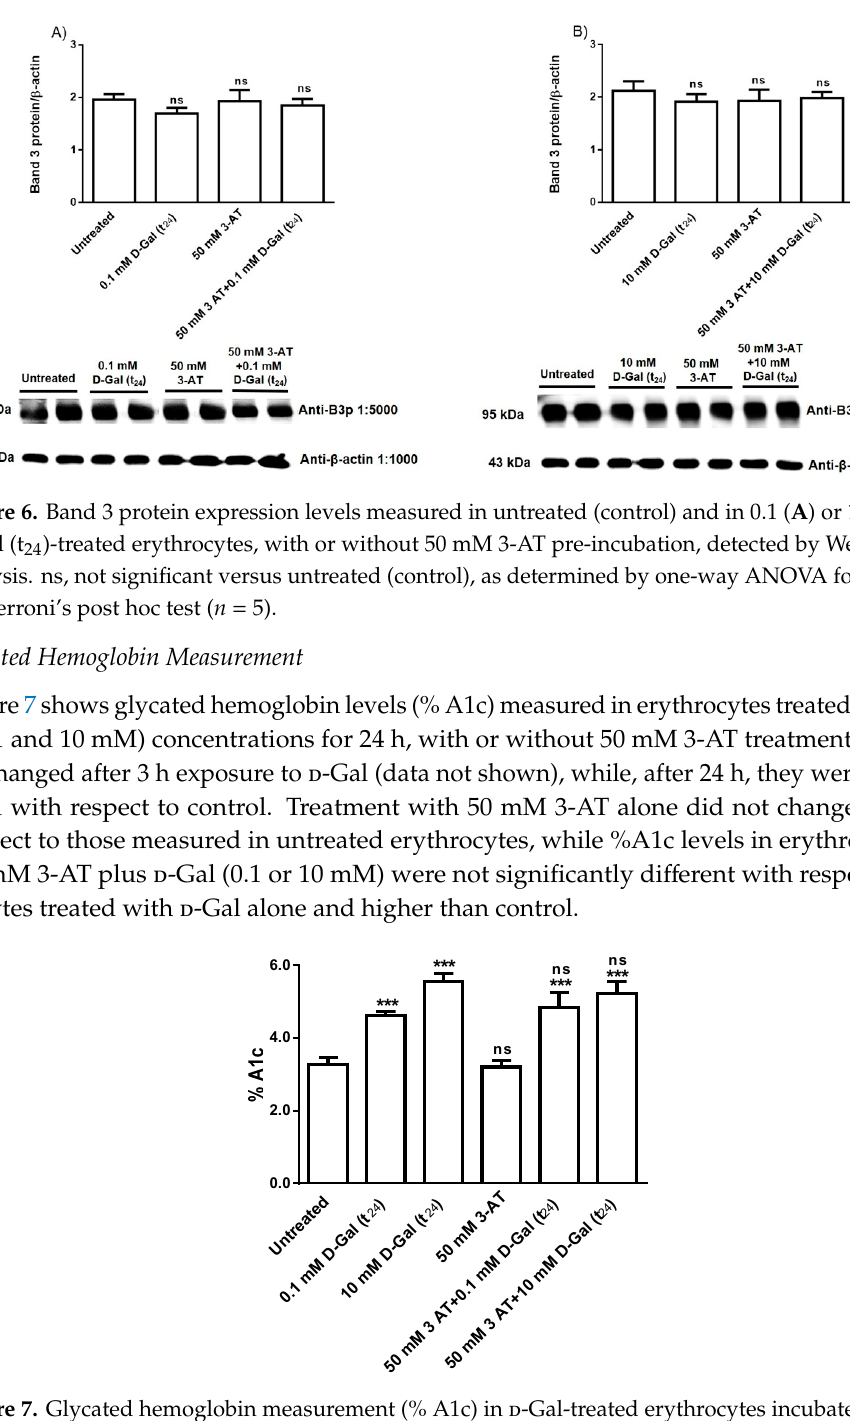
Figure 7. Glycated hemoglobin measurement (% A1c) in d -Gal-treated erythrocytes incubated for 24 h with di ff erent d -Gal concentrations (0.1 or 10 mM) with or without 50 mM 3-AT, *** , p < 0.001 versus untreated (control); ns, not significant versus both 0.1 mM d -Gal or 10 mM d -Gal, as determined by one way ANOVA followed by Bonferroni’s post hoc test ( n = 10).